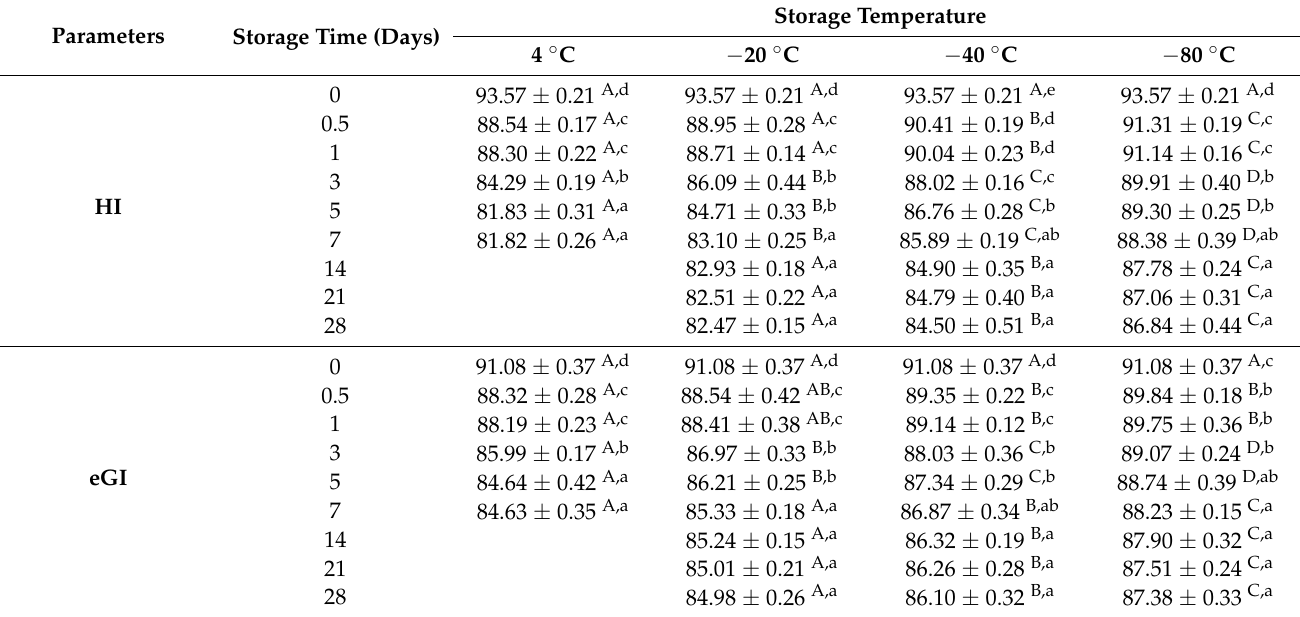
Table 2. Effect of storage temperatures and periods on the estimated glycemic index of cooked rice samples.